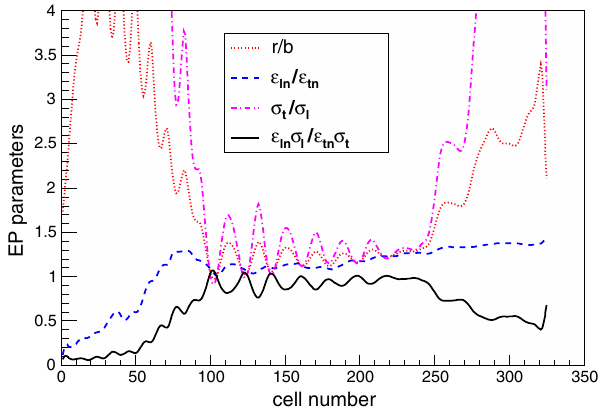
FIG. 5. Input-transverse-emittance dependence of the trans- mission. The solid, dashed, and dotted lines are transmissions for the input transverse emittances of 0.20, 0.25, and 0 : 30 (cid:1) mm mrad ,